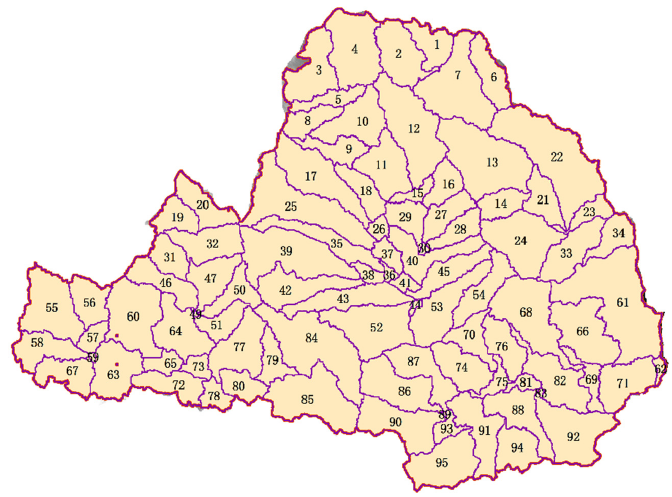
Figure 4. Sub-basins of the Wei River Basin (WRB) in the Soil and Water Assessment Tool (SWAT) model.